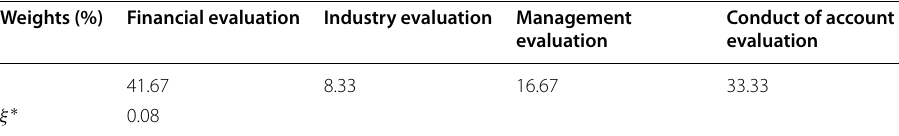
Table 4 Optimal weights for the main criteria Weights (%) Financial evaluation Industry evaluation Management